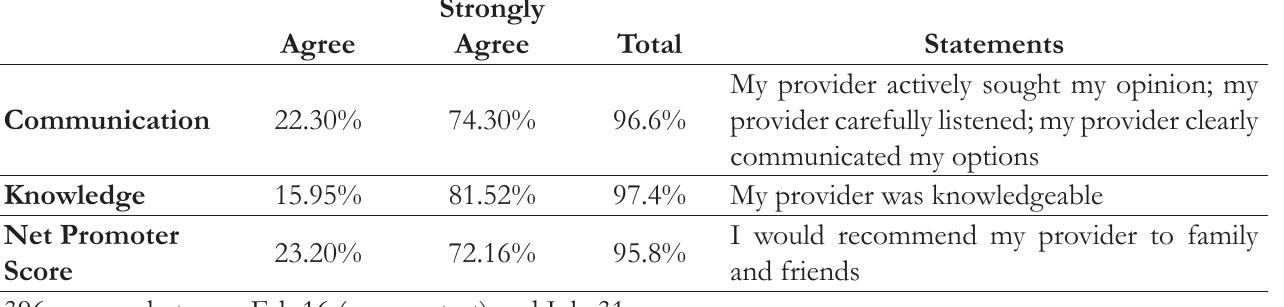
Table 5. Intervention Group Patient Experience